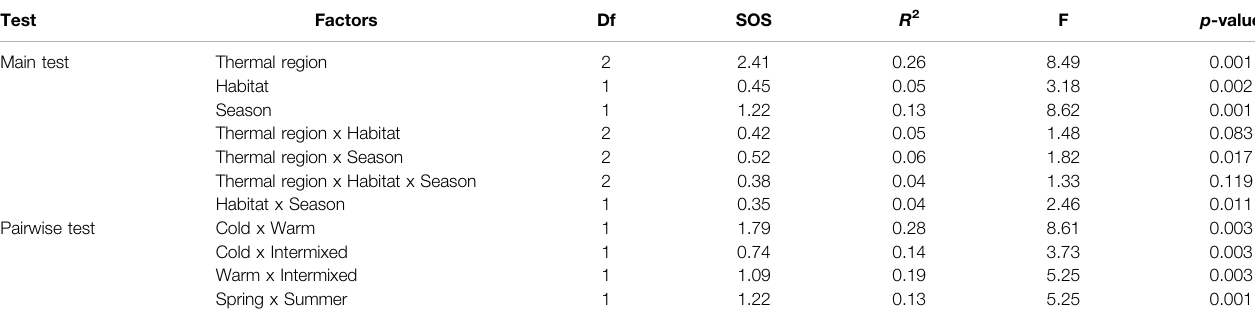
TABLE 4 | Results of the multivariate analyses of overall macroinvertebrate community composition using PERMANOVA with pairwise comparisons. Test Factors Df SOS R 2 F p -value Main